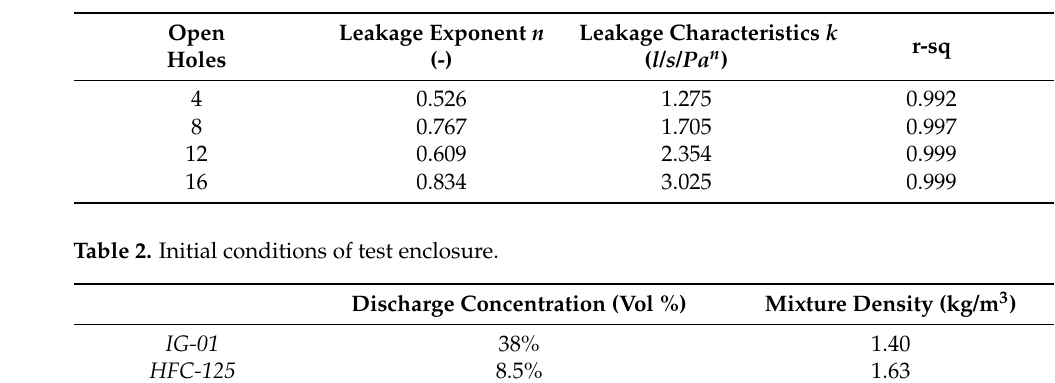
Table 1. Measured leakage exponent and leakage characteristics.